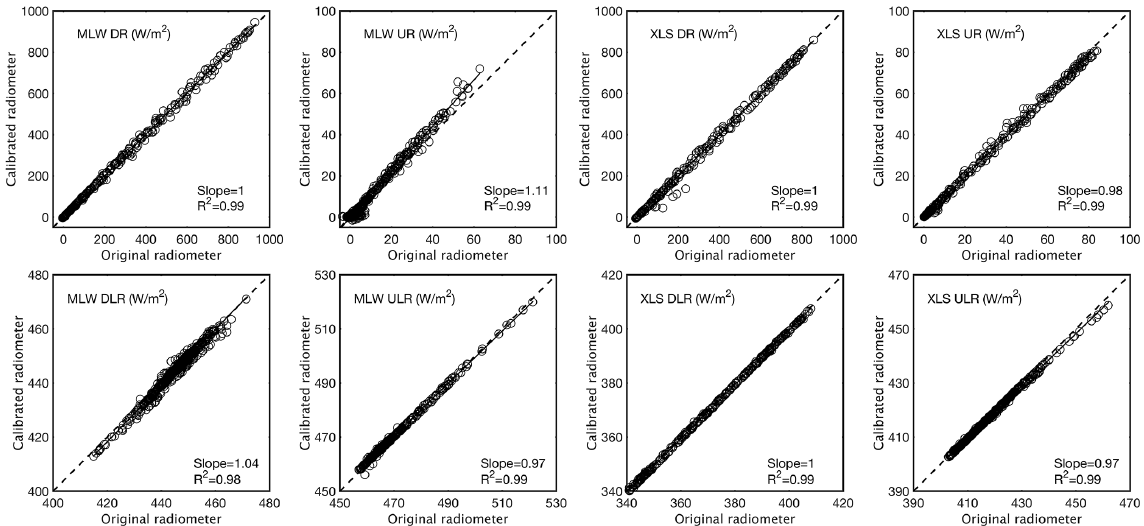
Figure 3. Comparison of four components of the radiation balance between the original radiometer (horizontal axis) and a laboratory standard (vertical axis) at MLW and XLS. Refer to Table 4 for variable